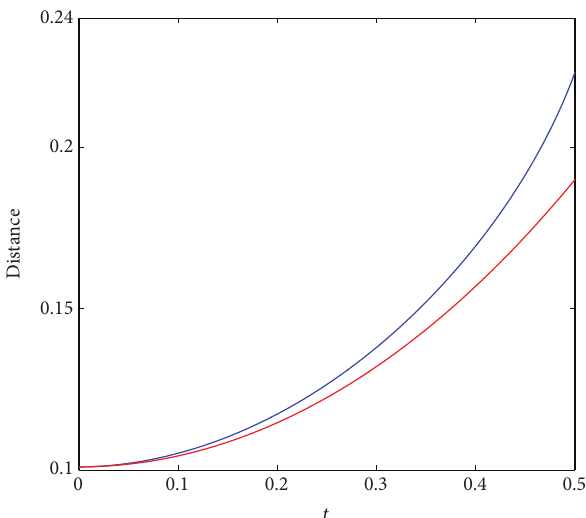
Figure 3: 𝑡 versus the distance (blue) ∑ 3 𝑗= 1 ‖𝑇 𝑗 (𝑡) − √ 2 / 3 𝑅 𝑗 (𝑡)‖ 2 𝐻𝑆 and (red) ∑ 3 𝑗= 1 ‖𝑇 𝑗 (𝑡) − 𝑆(𝑡) − 1 / 2 𝑇 𝑗 (𝑡)‖ 2 𝐻𝑆 in Example 12. Note that ( 0 )} 3 {𝑇 𝑗 𝑗= 1 is tight but needs rescaling to become the Parseval generalized frame {√ 2 / 3 𝑇 𝑗 ( 0 )} 3 𝑗= 1 . It is clear that 𝑅 𝑗 ( 0 ) = 𝑇 𝑗 ( 0